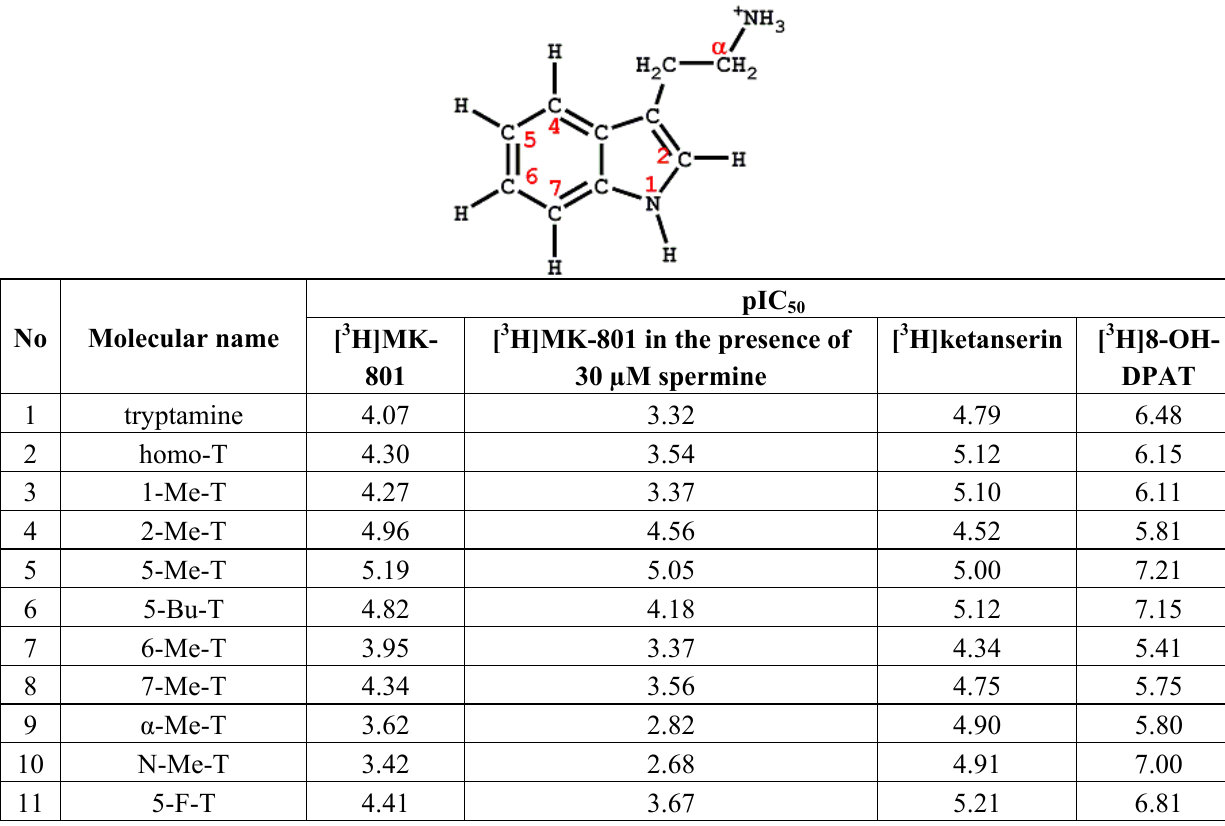
Table A1. Structures and experimental pIC values (M), inhibiting the binding of 50 [ 3 H]MK-801 in absence and presence of 30 µM spermine, and the binding of [ 3 H]ketanserin and of [ 3 H]8-OH-DPAT, for a series of Ts. Data are logarithmic transformations of the IC values published previously 50